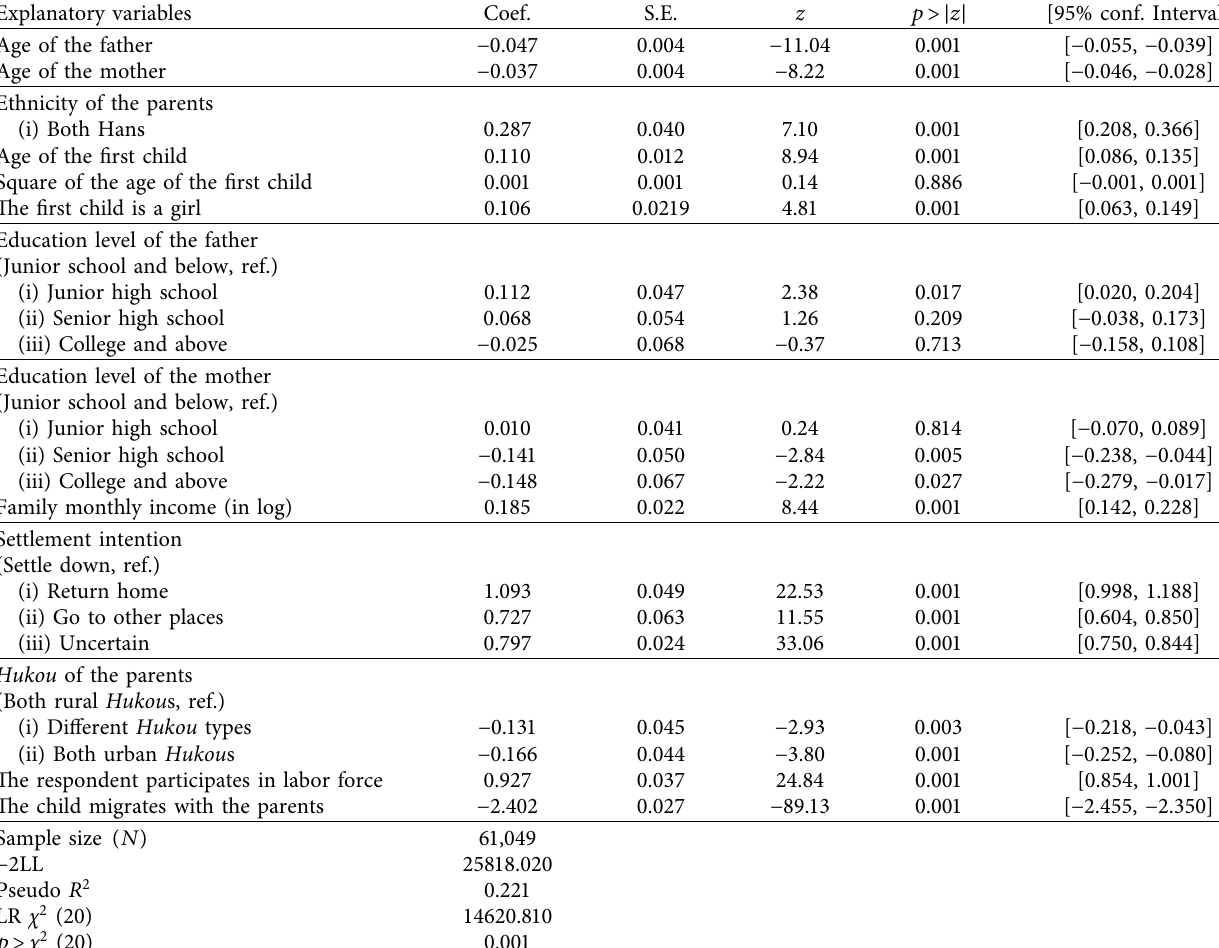
Table 2: The propensity score model: logistic regression results of factors affecting having grandparents as the primary-care provider for the first